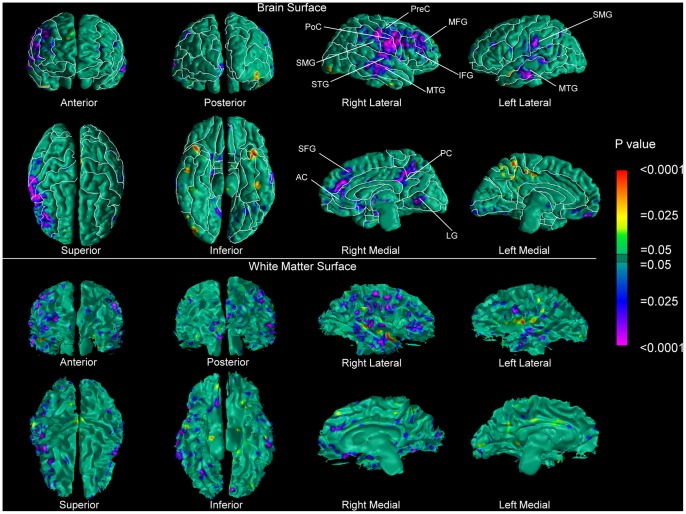
Maps of Group Differences in Local Volumes along the Surface of the Brain and of the Underlying WM in Persons with Schizophrenia Compared with Healthy Controls.At each point on the brain or on the WM surface, the statistical significance of differences in local volumes between patients (n = 76) and healthy controls (n = 57) is color-coded. Warm colors (yellow, orange and red) represent significantly greater local volumes of brain tissue along the surface of the brain or of WM tissue along the underlying WM surface in the schizophrenia group. Cooler colors (blue and purple) represent reduced local volumes of brain tissue along the surface of the brain or of WM tissue along the underlying WM surface in that group. The color bar indicates the color-coding of p values for testing of statistical significance at each point. Brain and WM surfaces were rescaled for whole brain size and the statistical models accounted for age, age2 and the gender of all participants. P values are thresholded at P<0.05 with corrections for multiple statistical comparisons using the theory of Gaussian Random Fields (GRF) on a 2D manifold. P values are displayed onto the ICBM brain surface of the template brain (in green) and onto the WM surface of the reference subject. More specifically, abnormalities in WM surface, brain surface, and cortical thickness are overlaid on the same reference brain. However, while brain surface and cortical thickness results can be displayed on a brain surface, WM results must be displayed on the WM surface of the reference brain after its cortical mantle has been removed. This figure shows that reduced local volumes of brain tissue along the surface of the brain are distributed in perisylvian regions and they closely reflect underlying reductions in local volumes along the WM surface. AC, anterior cingulate; IFG, inferior frontal; LG, lingual gyrus; MFG, middle frontal gyrus; MTG, middle temporal gyrus; PreC, precentral gyrus; PC posterior cingulate; PoC, postcentral gyrus; SFG, superior frontal gyrus; SMG, supramarginal gyrus; STG, superior temporal gyrus.